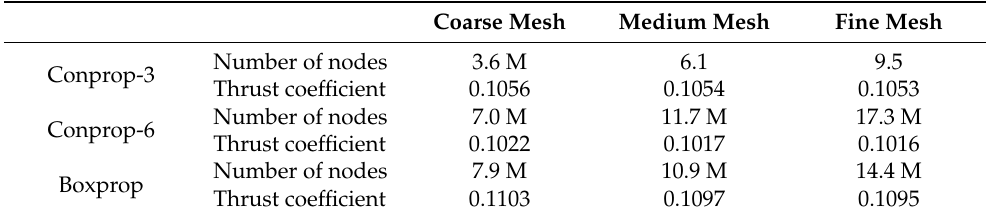
Table 3. The total number of nodes in Zone 1 and the aerodynamic parameters in the mesh indepen- dence study.